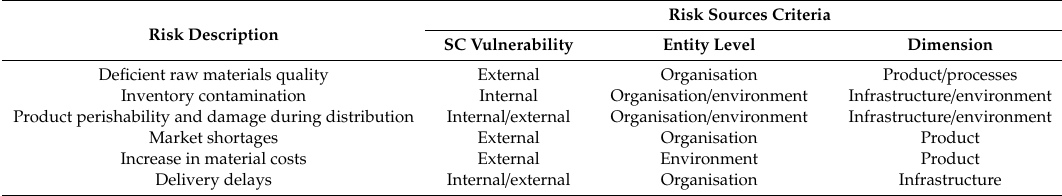
Table 3. Risks considered when applying stage 2 of Supply Chain Outline Process with Risk (SCOP-R) to the case study. The cells show the risk source for each criterion indicated in the columns, for each risk described in the